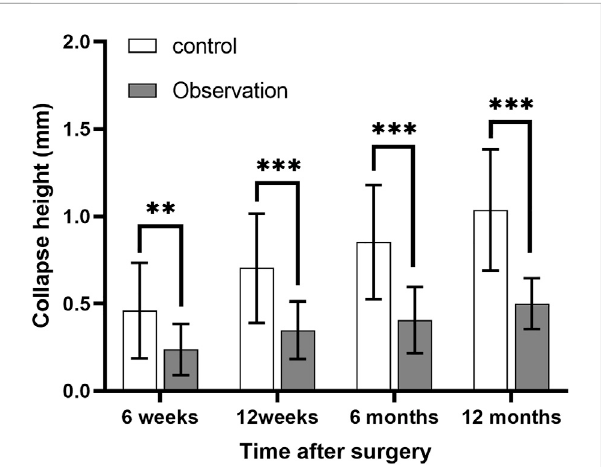
Comparison of the depth of tibial plateau collapse between the control and observation groups. ** p < 0.01, *** p <